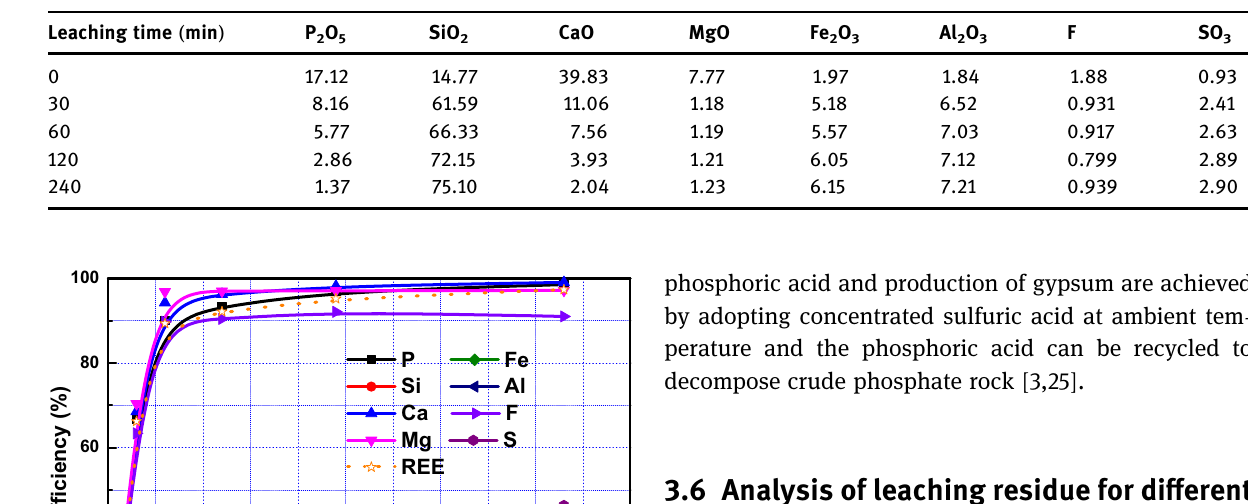
Table 4: Chemical analysis of leaching residue after di ff erent leaching time ( wt% )